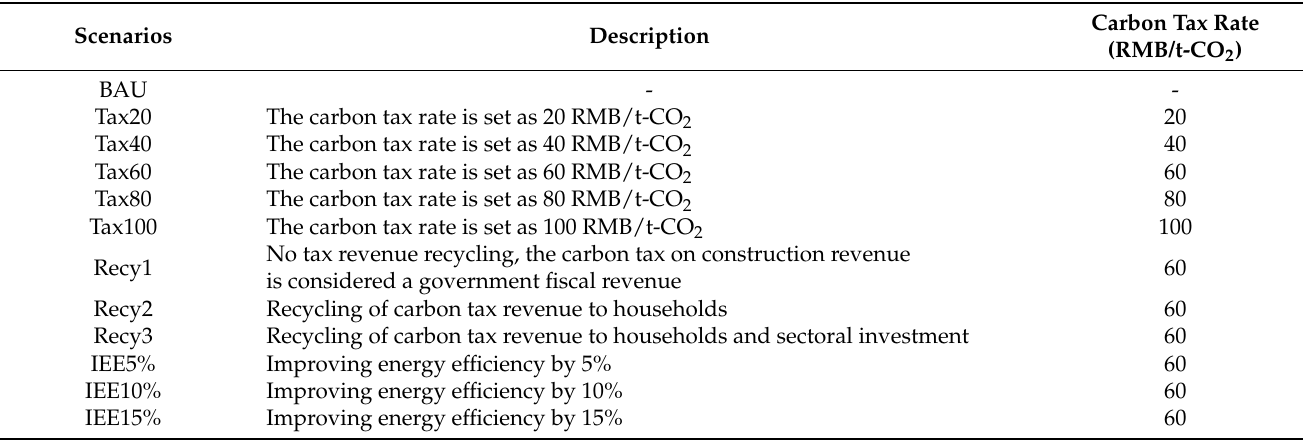
Table 2. Scenarios for CGE model simulation.